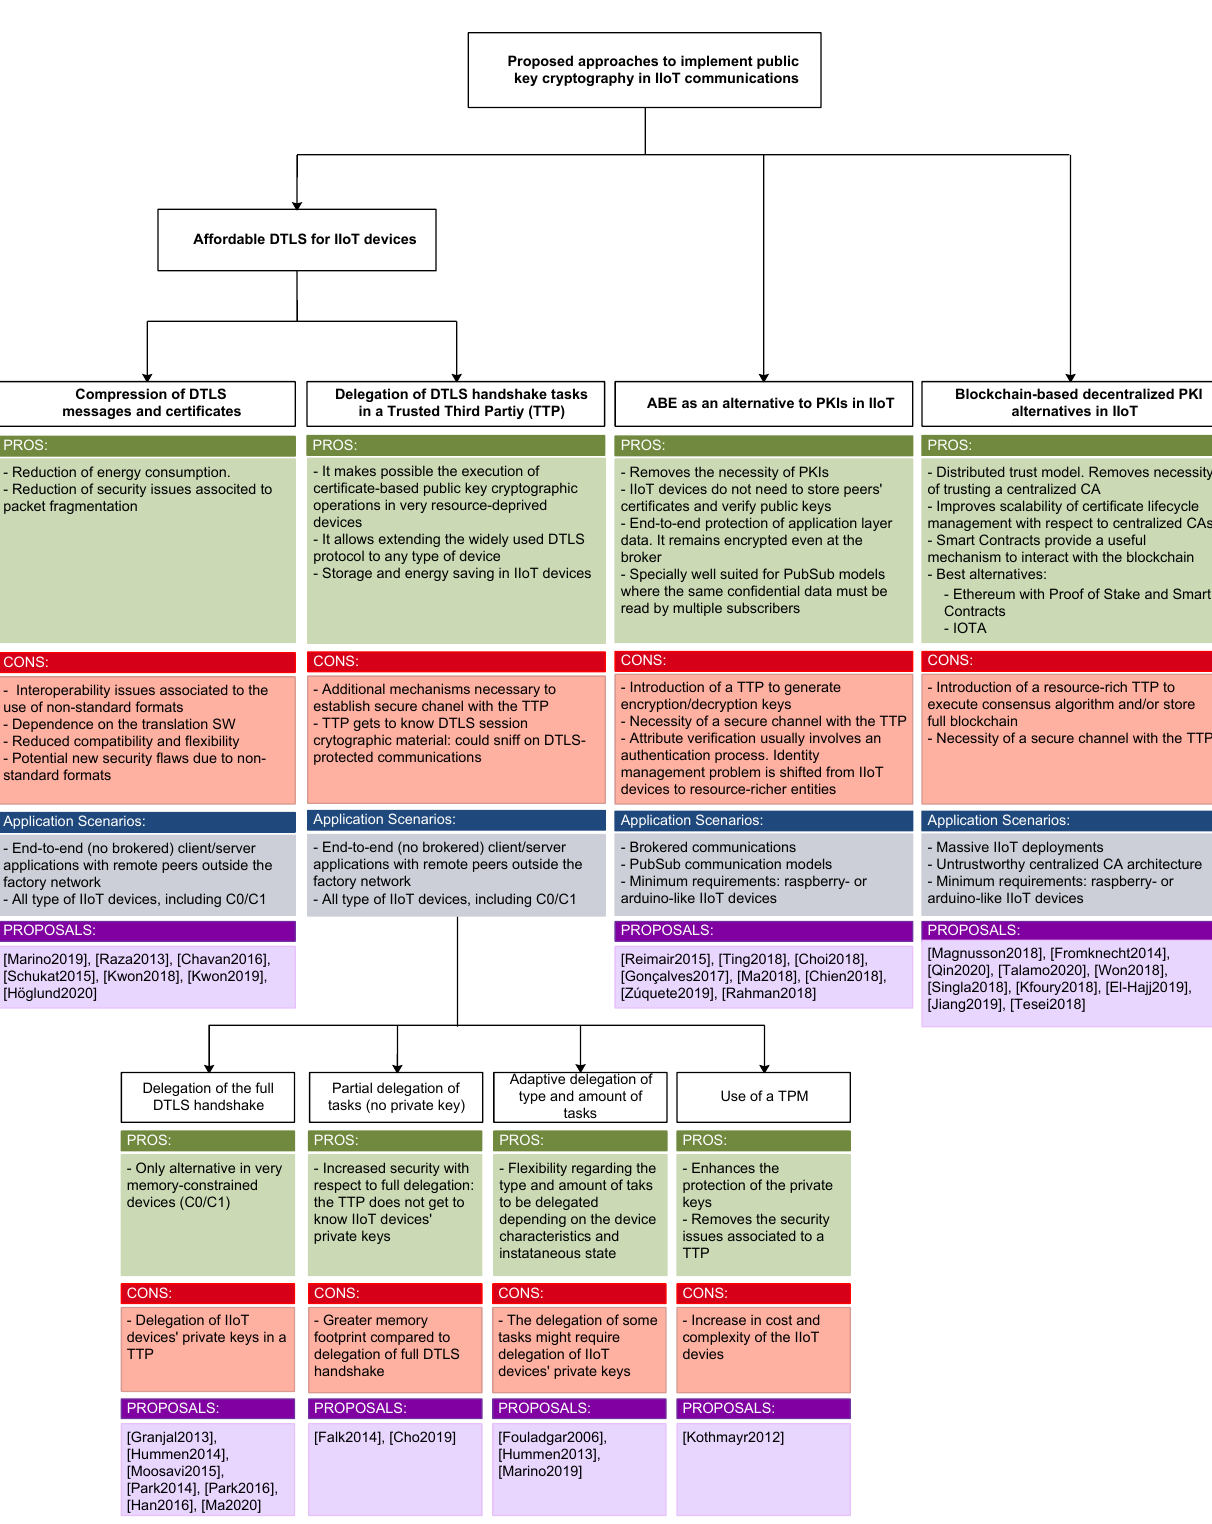
The delegation of DTLS handshake tasks is sometimes the only feasible approach to enable the participation of IIoT devices in end-to-end client/server communications